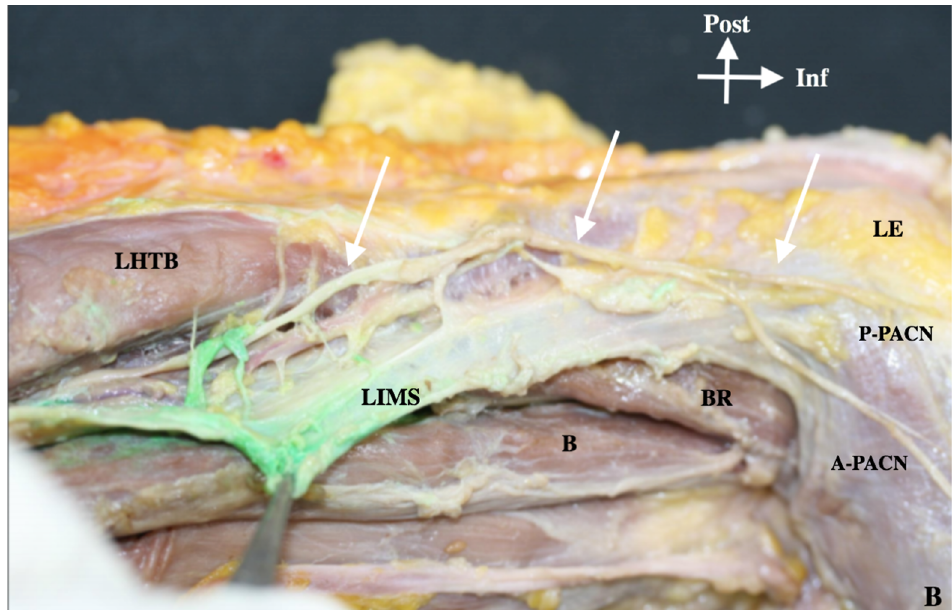
Figure 4. ( A ) Posterior antebrachial cutaneous nerve (PACN) separated from the radial nerve (16%) that in the picture is deep to the LHTB longitudinal aponeurosis, just before it crosses the LIMS (16%). PACN ran alone inside the muscular fibers of the triceps brachii muscle in a canal formed by the perimysium and aponeurotic bands of this muscle. Lateral intermuscular septum (LIMS), lateral head triceps brachii muscle (LHTB), deep fascia (DF). ( B ) Common and classical course of the PACN (white arrows) that ran along the posterior side of the lateral intermuscular septum (LIMS) until it pierced the deep fascia in this posterior compartment (63%) and divided into two branches, an anterior PACN (A-PACN) and a posterior PACN (P-PACN). Brachialis muscle (B), brachioradialis muscle (BR), lateral epicondyle (LE).